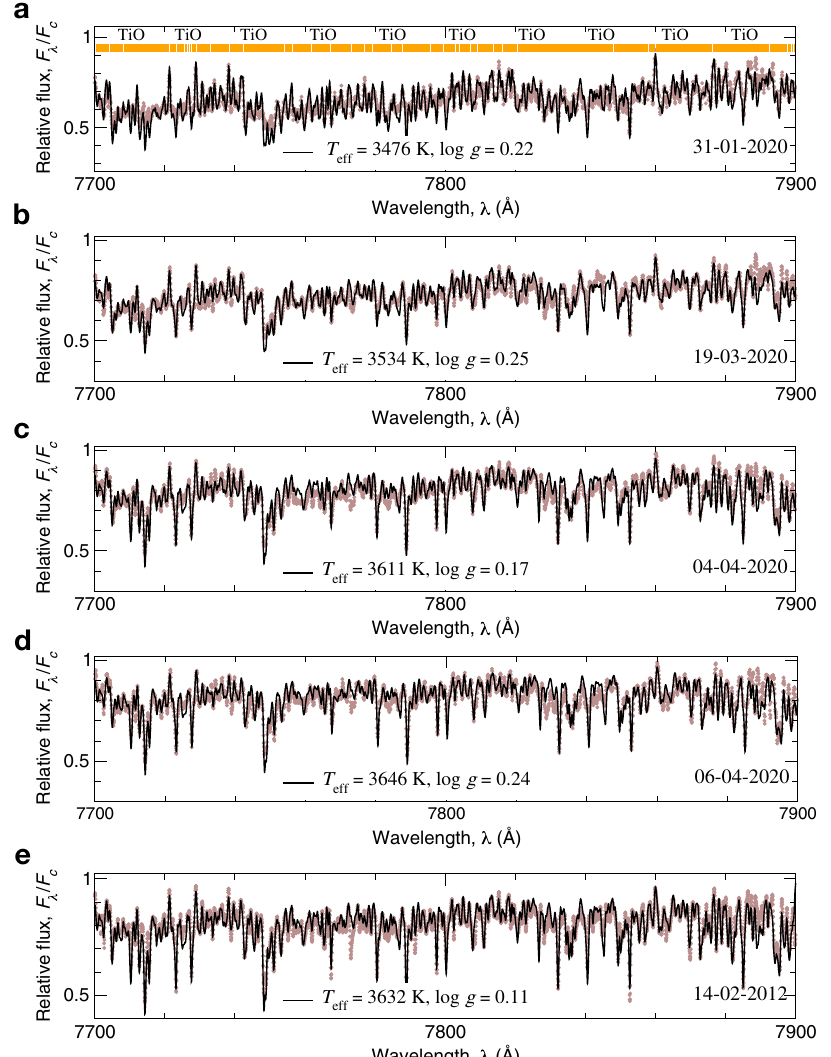
Fig. 7 Best fi ts to the molecular bands of TiO for fi ve sets of spectra. The observed spectra of Betelgeuse obtained on 31-01-2020 ( a ), 19-03-2020 ( b ), 04-04-2020 ( c ), 06-04-2020 ( d ), and 14-02-2012 ( e ) are shown by brown dots. The solid line is a theoretical pro fi le calculated with the particular effective temperature ( T eff ) and surface gravity (log g ), which were obtained in this study and presented on each panel. Relative fl ux is calculated as a ratio of the fl ux at a particular wavelength ( F λ ) to the fl ux in continuum ( F c ). The 2365 TiO lines are marked by vertical lines on the a . Source data are provided as a Source Data fi